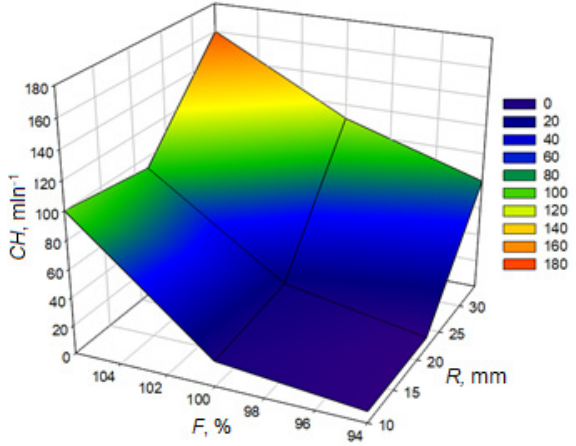
Figure 11. The dependence of CH content on the capacity of the electromagnetic nozzle F and the resistance of the catalytic converter R (at the spark plug gap Z =1.1 mm = const and a 20% throttle opening degree)